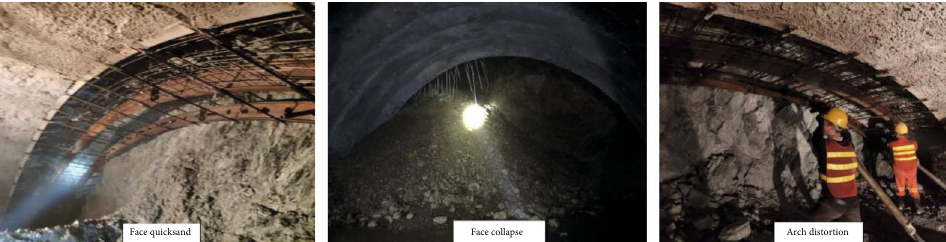
Figure 1: Tunnel face accident.